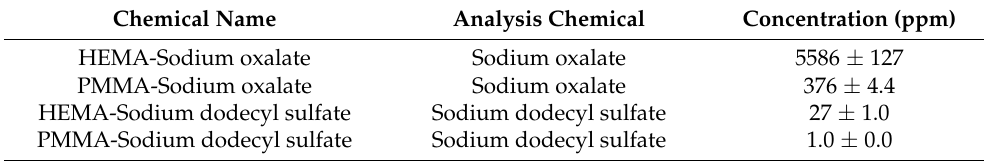
Table 4. Chemical analysis data using